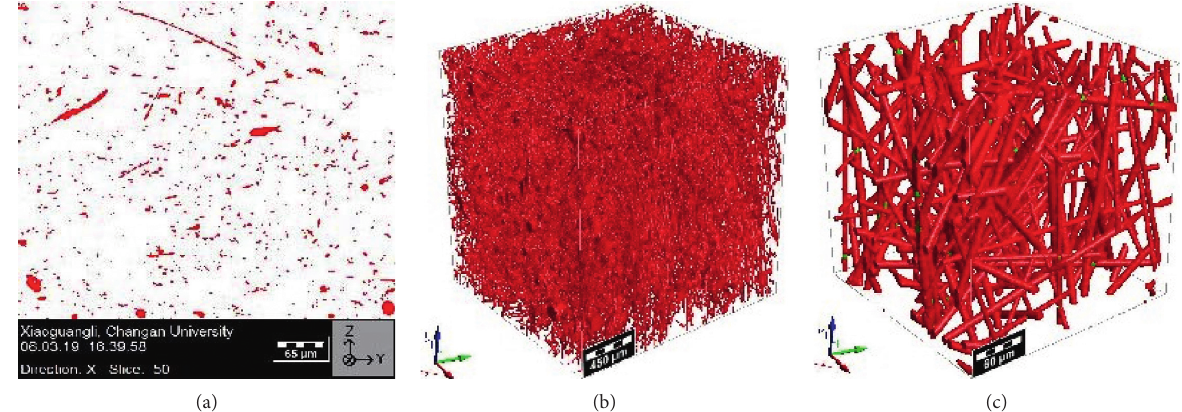
Figure 5: Model of the RWB: (a) cross section; (b) original model; (c) ideal model.